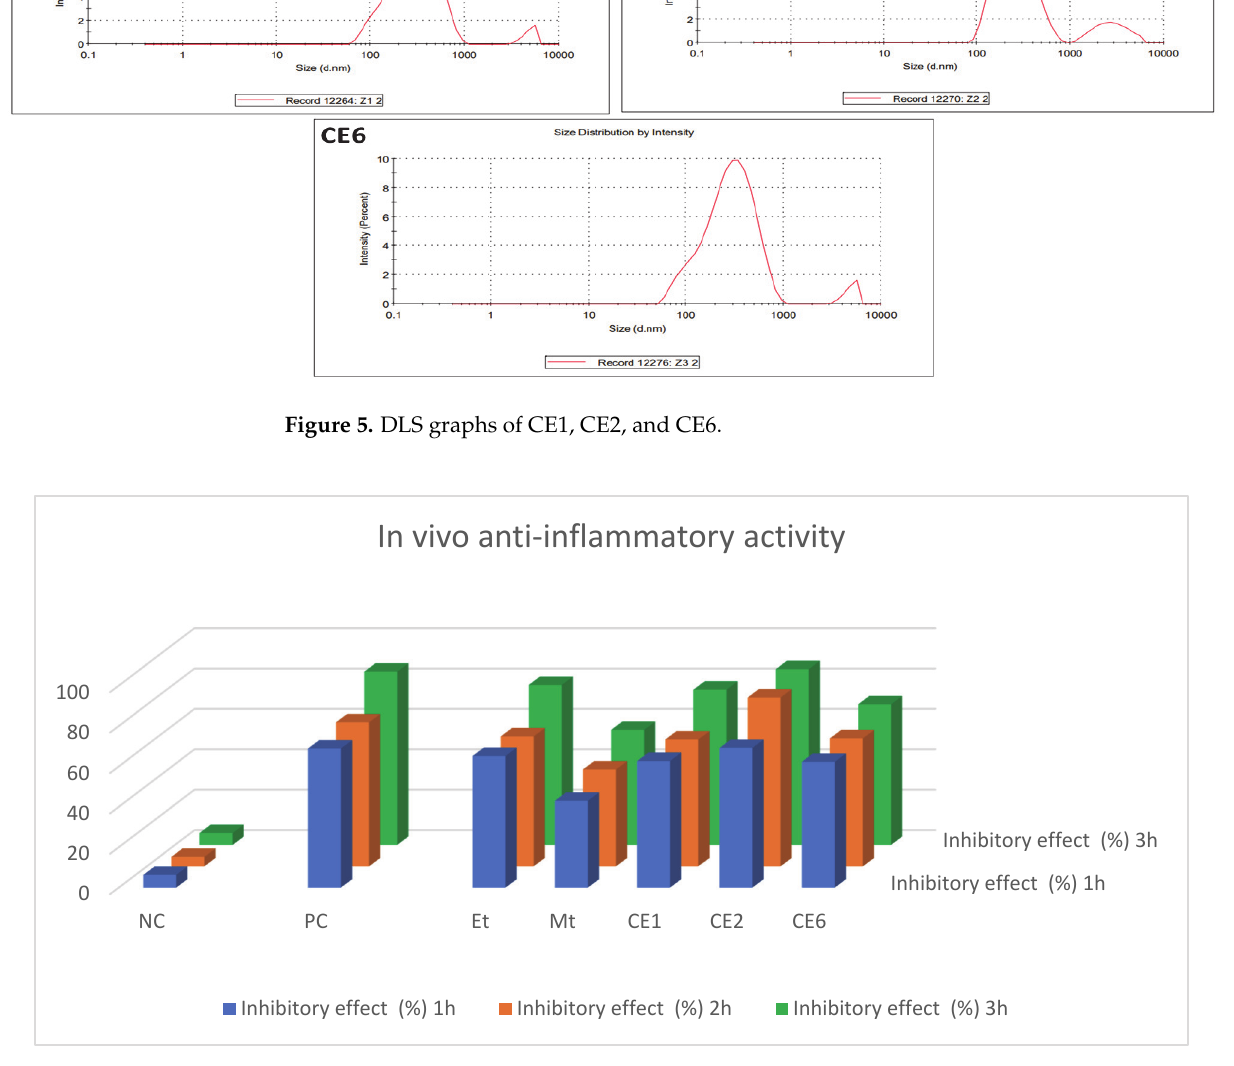
Figure 6. Graphical representation of in vivo anti-inflammatory activity. PC—positive control, NC—negative control. Table 2. Quantity of etoricoxib and montelukast in 5 mg of each nanoformulation.